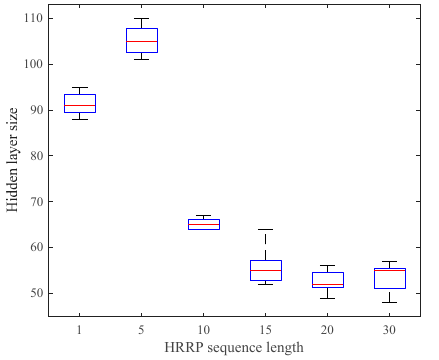
Figure 5. Effective hidden layer sizes of Dis-iRBMs trained on the data with different sequence lengths.